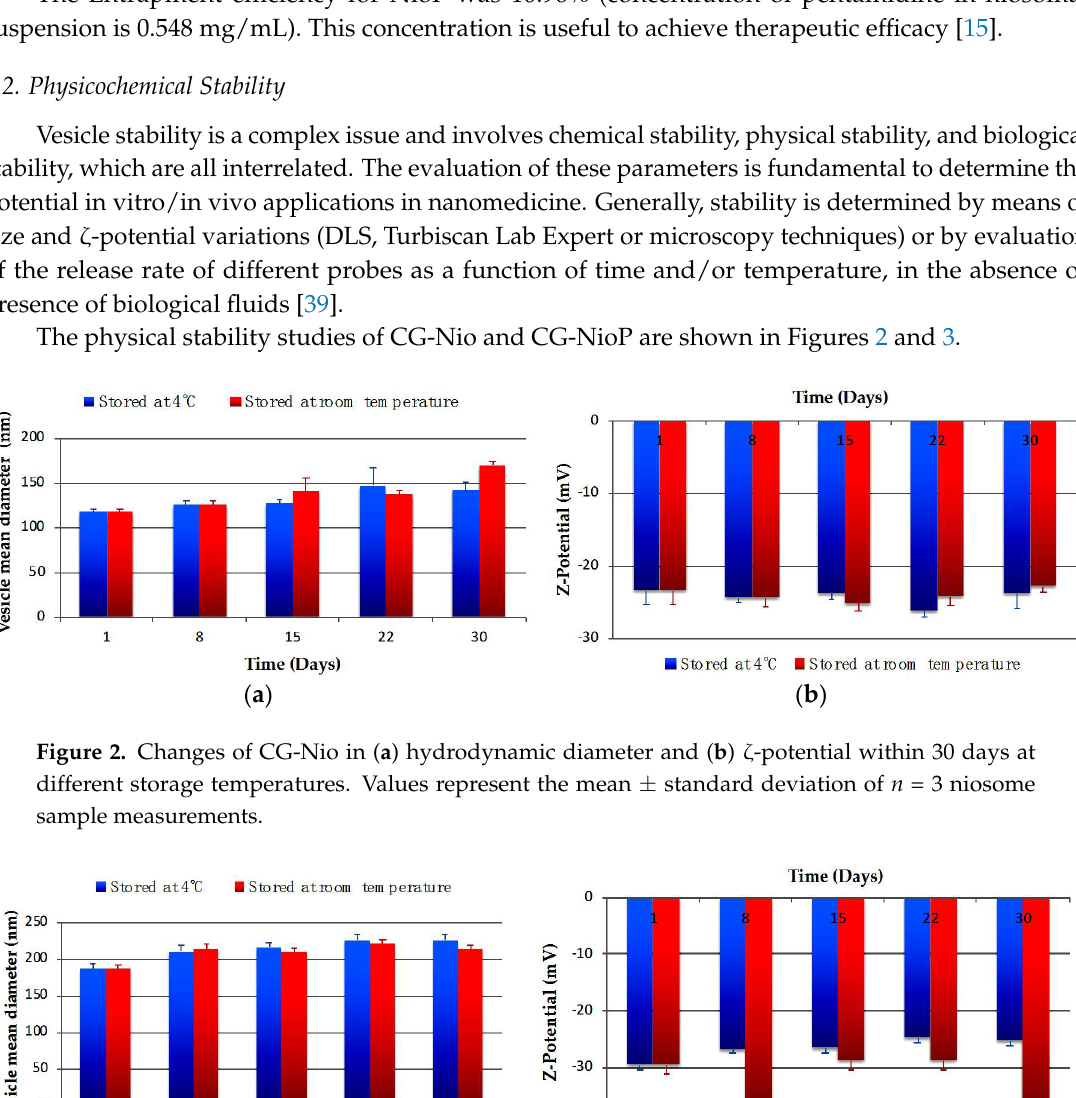
Figure 1. Microscopic images using AFM. ( a ) uncoated niosomes (Nio); ( b ) uncoated niosomes with pentamidine (NioP); ( c ) chitosan glutamate coated niosomes (CG-Nio); ( d ) chitosan glutamate coated niosomes with pentamidine (CG-NioP) .